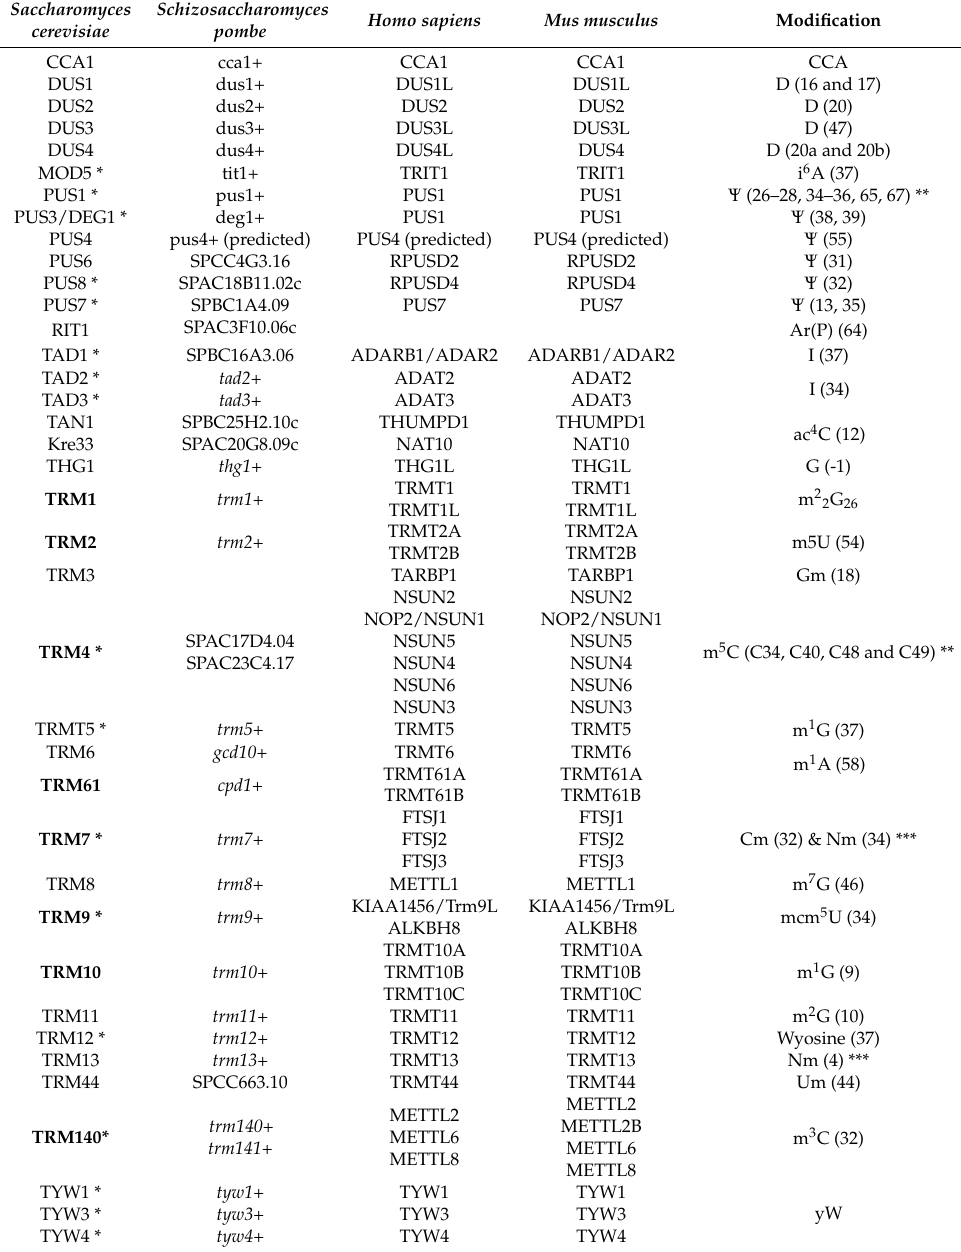
Table 2. Sequence homologs of S. cerevisiae tRNA modification enzymes in S. pombe , mouse and human. Homologs of enzymes listed in [36] were identified by BLASTp analysis